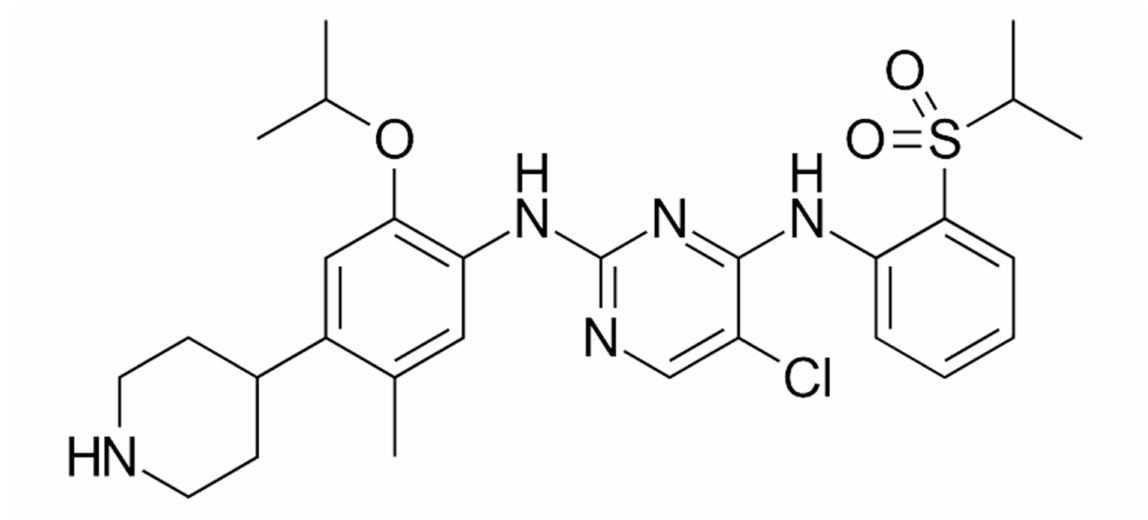
Figure 10. Ceritinib—a second-generation ALK